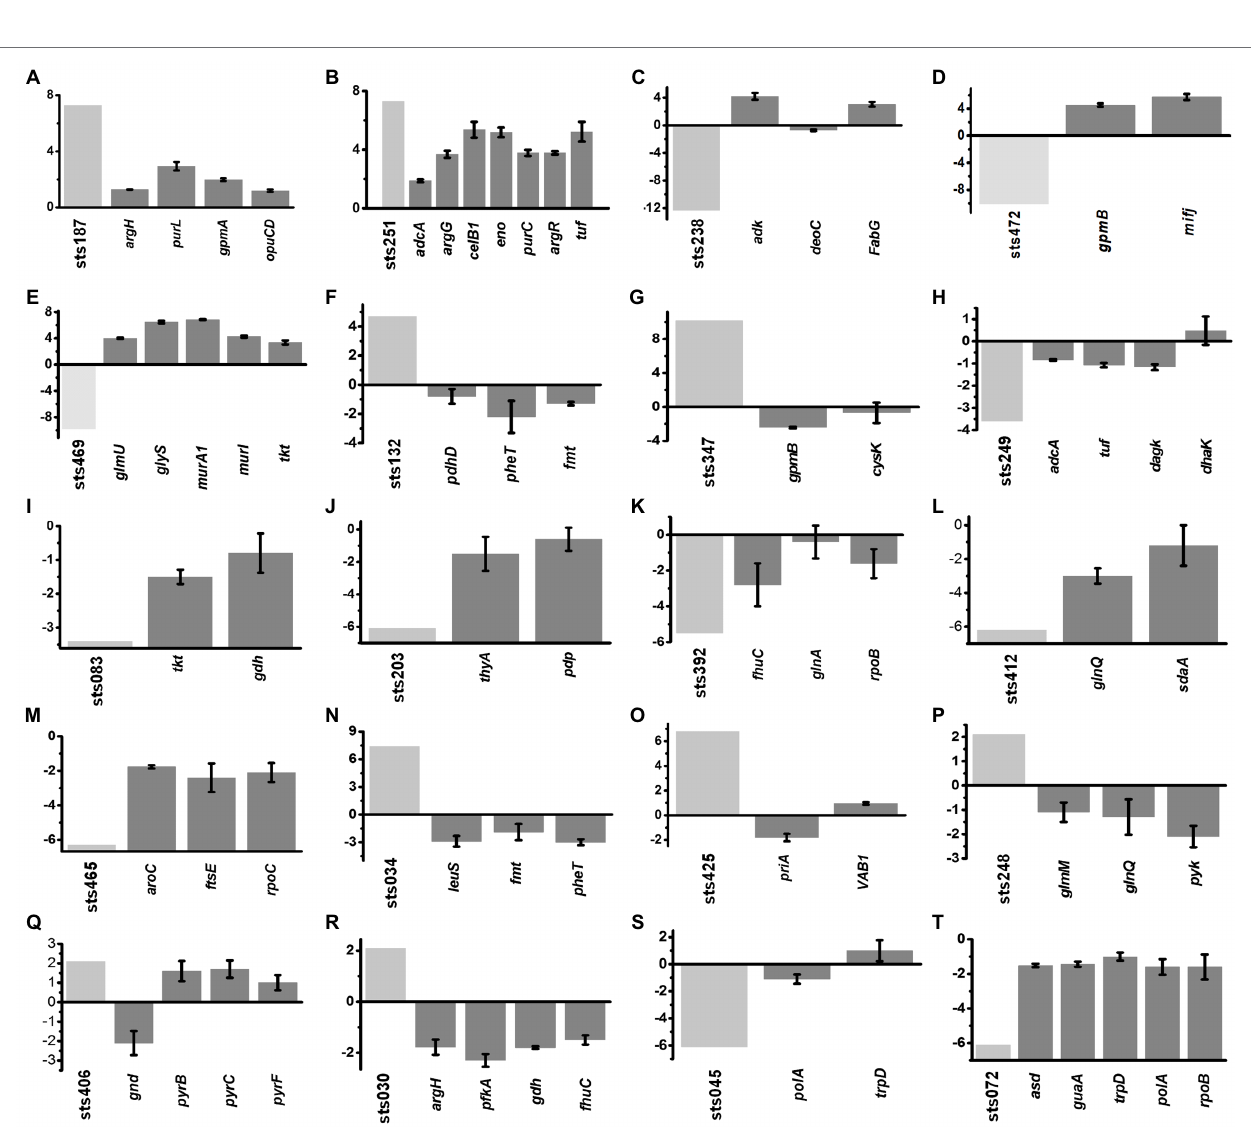
FIGURE 5 | (A-T) Correlation between the expression of sRNAs and their target genes. The expression levels of the sRNAs (light gray) that were significantly changed in each growth phase were compared with the expression levels of the corresponding target genes (gray). Error bars indicate the mean ± SD of three biological and three technical